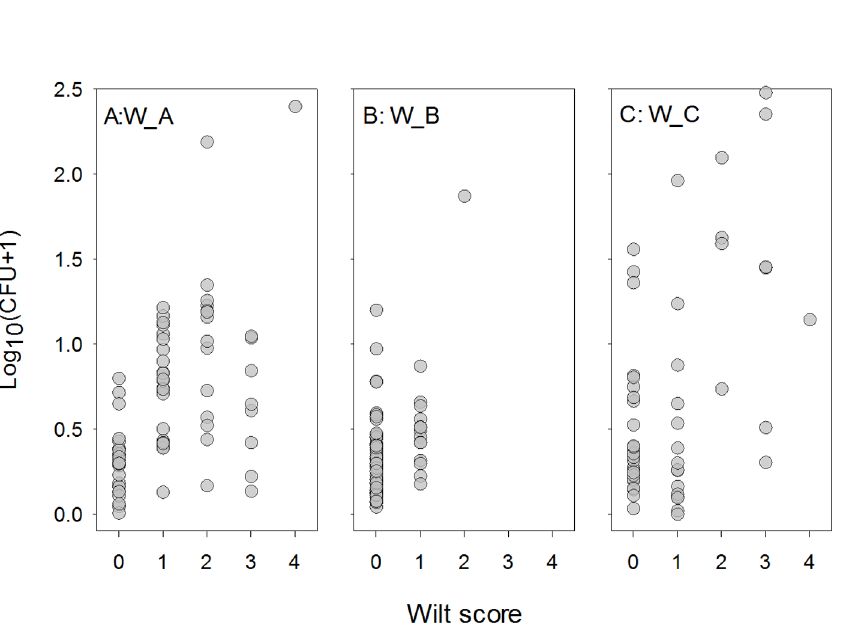
Fig 6. Estimated Verticillium dahliae inoculum densities in soil plotted against wilt scores of individual plants. These plantations (W_A, W_B, W_C) were located in Weinan, Shaanxi. The distance between soil sampling points and the plant stem was ca. 15 cm. Wilt on each plant in each plant was scored as: 0 — no symptoms; 1 — leaves with wilt symptoms (cid:2) 25%; 2 — leaves with wilt symptoms > 25% and (cid:2) 50%; 3 — leaves with wilt symptoms > 50% and (cid:2) 75%; and 4 — > 75% leaves with wilt